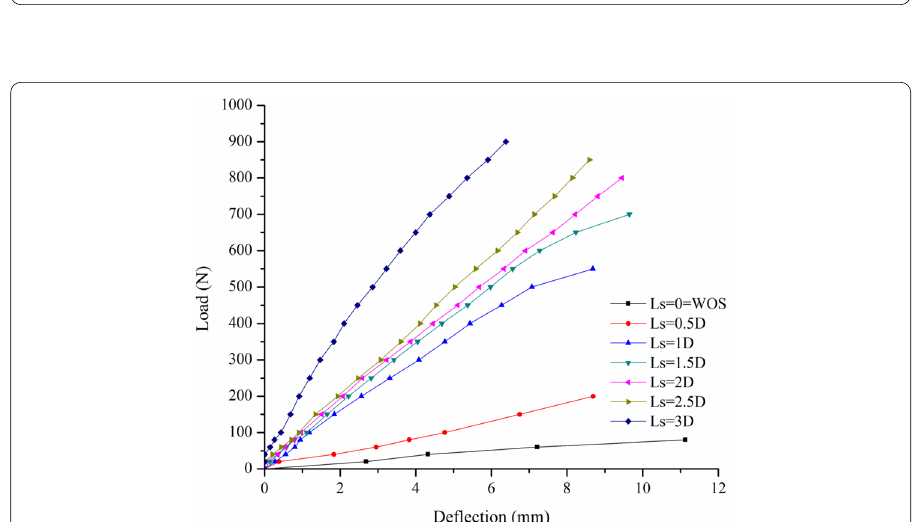
Fig. 7 Lateral load defection behavoiur of 50.8 mm diameter pile with embedded depth of 400 mm